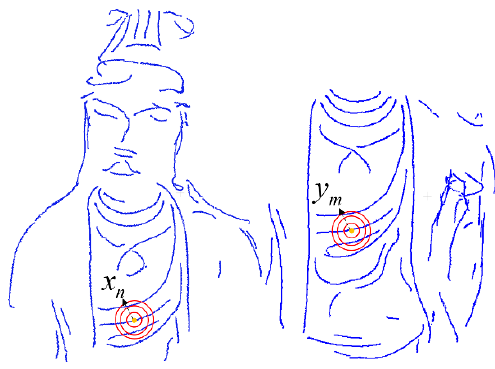
Figure 9. Schematic diagram of curve constraints: red circles indicate neighborhood areas of three scales from two point clouds.